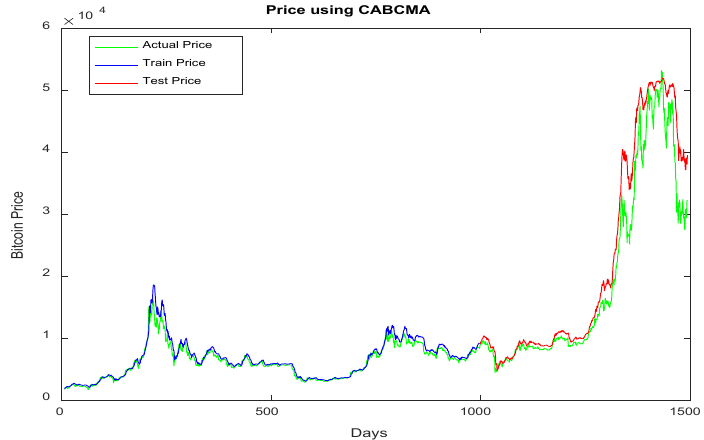
Figure 5. Bitcoin prices using CMCMA for BTC/EUR dataset.